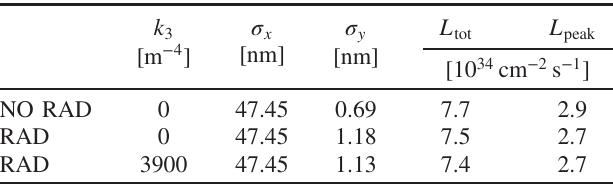
TABLE IV. Effect of the octupolar corrector on the beam size, total luminosity, and peak luminosity.